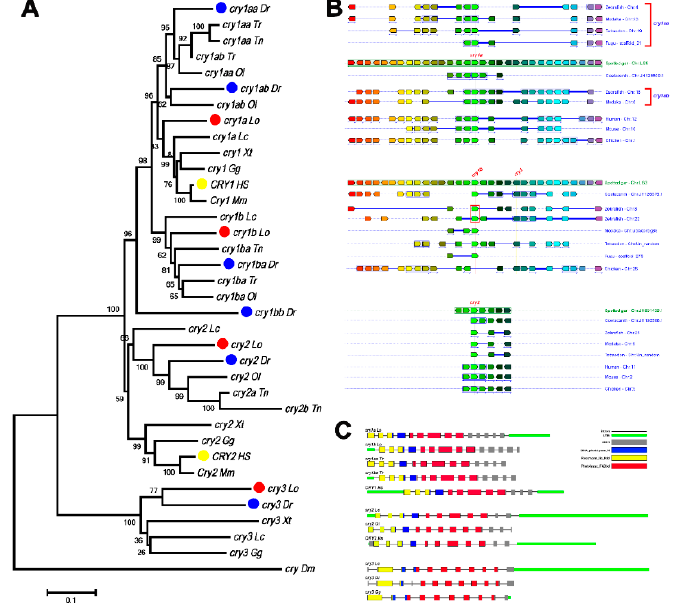
Figure 3. The phylogenetic, conserved syntenic, and exon structural analyses of the cry family. ( A ) Phylogenetic trees based on sequences of cry genes. The tree was constructed by the neighbor-joining method with MEGA6, and the numbers on the nodes are the percent bootstrap values based on 1000 pseudoreplications. The outgroup is Drosophila melanogaster cry . Red dots indicate spotted gar genes, blue dots indicate zebrafish genes, and yellow dots indicate human genes. ( B ) The conserved synteny surrounding the cry1a , cry1b / cry3 , and cry2 genes in chromosomes of coelacanth, spotted gar, zebrafish, medaka, teraodon, fugu, chickens, mice, and humans. The chromosome number or linkage group number is shown to the right of the chromosomes. The same colored rectangles represent the orthologous genes. Red and blue boxes indicate the duplicated genes. ( C ) The exonic structures of cry genes in spotted gar, medaka, fugu, chickens and humans. The boxes represent the exons. The size of each exon is drawn to scale.